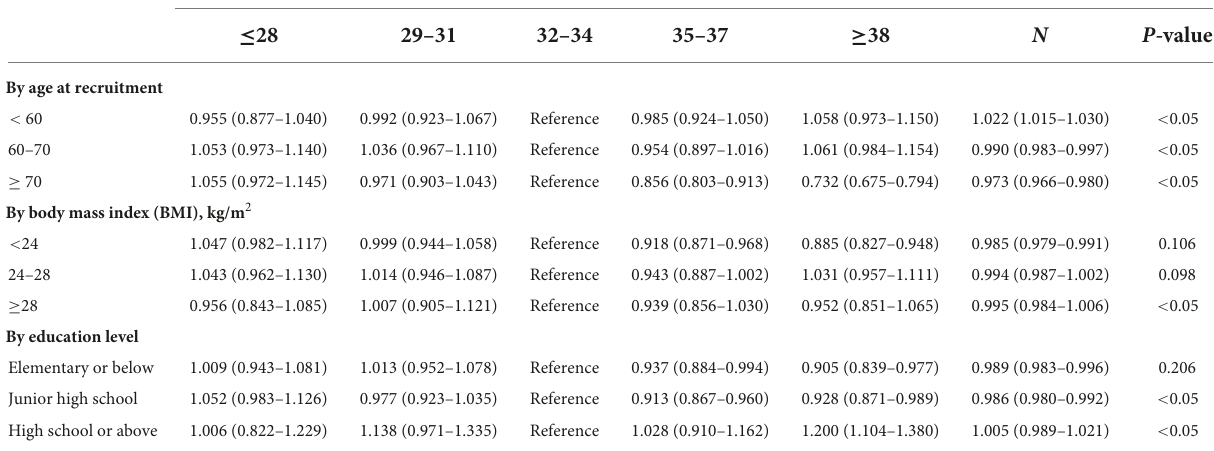
TABLE 2 Association between reproductive lifespan and risk of